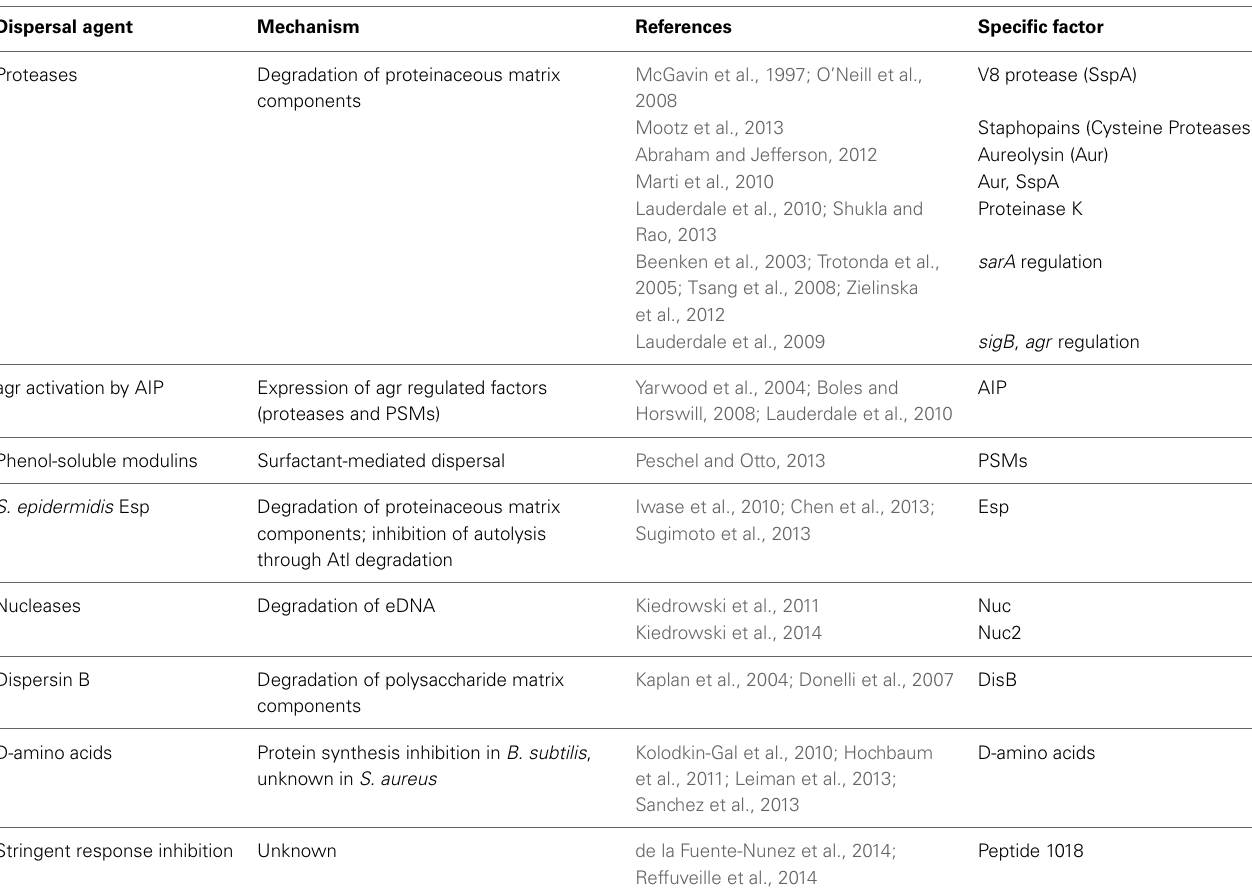
Table 1 | Biofilm dispersal